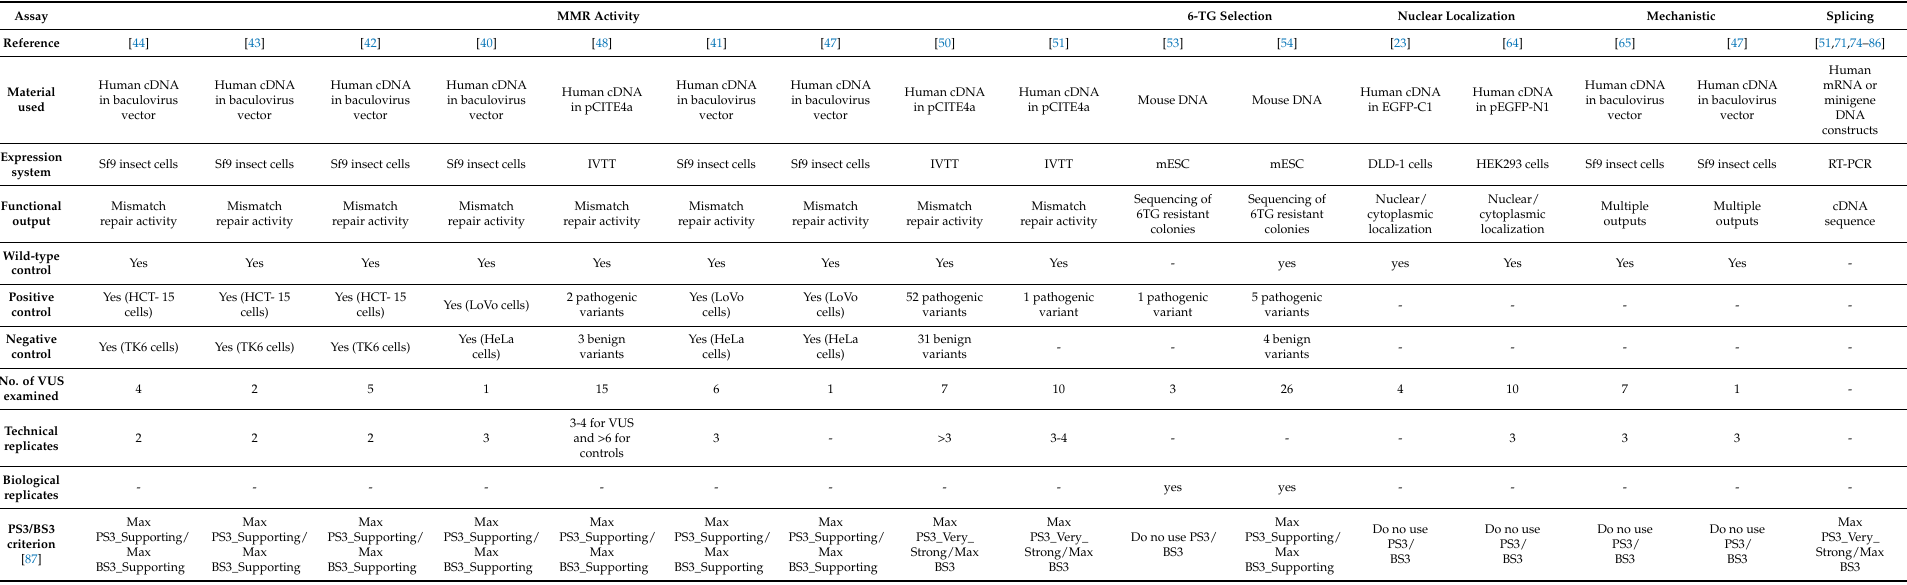
Table 2. Evaluation of functional studies examining MSH6